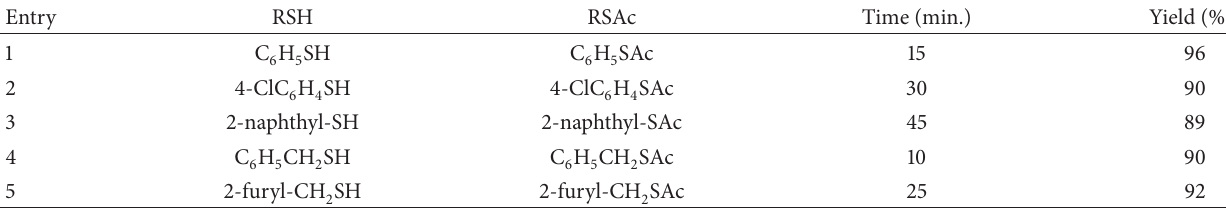
Table 2: Room-temperature NaOAc catalyzed acetylation of thiols.